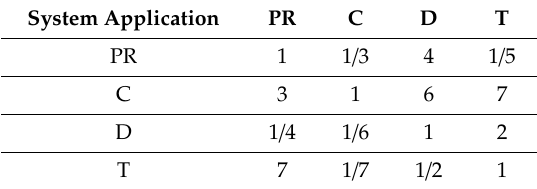
Table 7. The pairwise comparison matrix for the network attributes for system